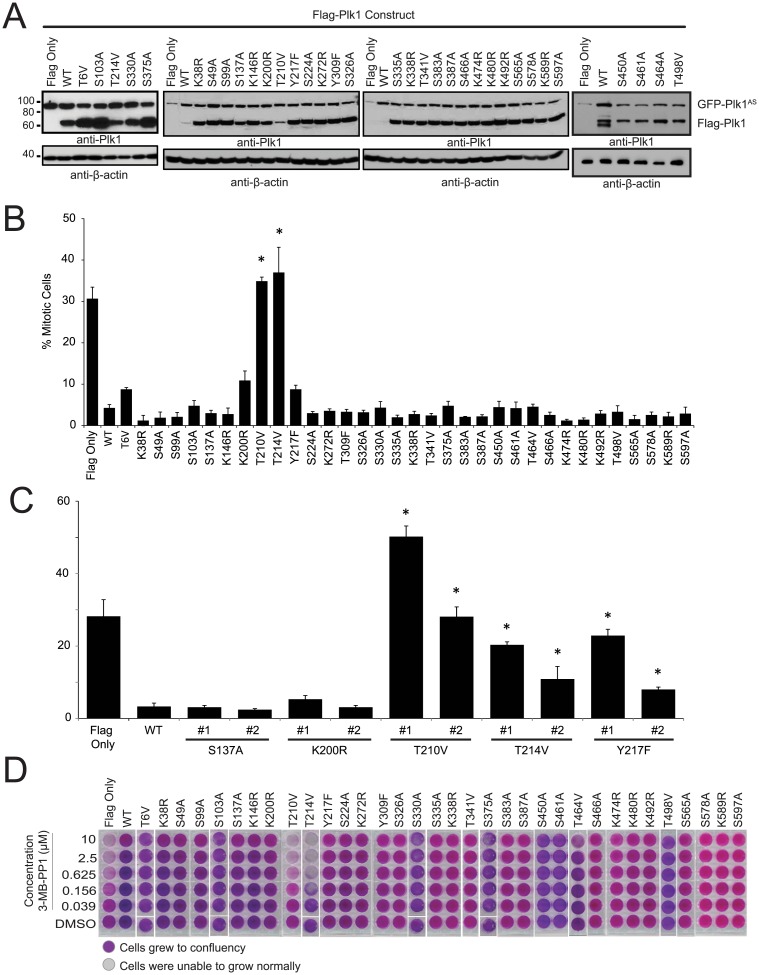
Plk1 T214V disrupts progression of mitosis and cell proliferation.(A) Western blots showing the expression of analog sensitive Plk1 (GFP-Plk1AS) and Flag-tagged Plk1 (Flag-Plk1) constructs with and without different S/T mutations in RPE cell lines. Cells were synchronized in mitosis with nocodazole prior to collection. Blot probed with anti-Plk1 (upper) and anti-β-actin (lower) antibodies. (B) Mitotic index of AS cell lines in (A) treated with 10μM 3-MB-PP1 for 16 hours. 900 cells were scored as mitotic or non-mitotic through Hoechst 33258 staining. n≥3, *p<0.05 compared to WT (GFP-Plk1AS/Flag-Plk1WT). (C) Mitotic index of Flag only and monoclonal AS cell lines in (S1A Fig) treated with 10μM 3-MB-PP1 for 16 hours. 900 cells were scored as mitotic or non-mitotic through Hoechst 33258 staining. n≥3, *p<0.05 compared to WT Clone (GFP-Plk1AS/Flag-Plk1WT). (D) 6000 cells were plated in complete medium and treated with concentrations of 3-MB-PP1 as indicated, and allowed to grow until control (DMSO) wells were confluent (six days). Cell density is qualitatively detected by crystal violet staining